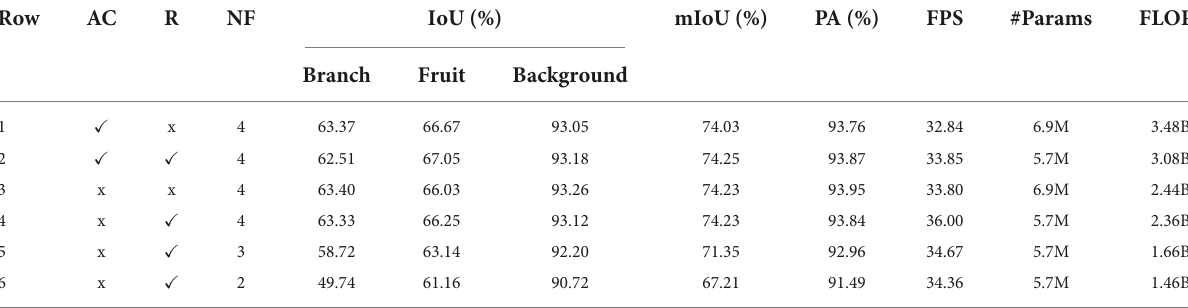
TABLE 1 Ablations on the backbone and feature aggregation